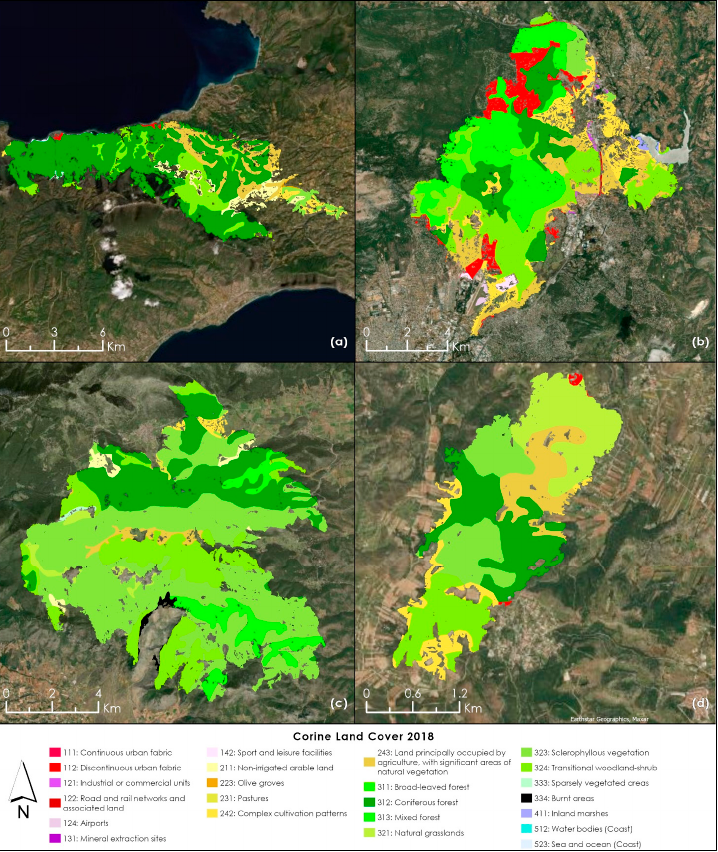
Figure 4. Burned land cover of Attica region wildfires based on Corine Land Cover 2018: ( a ) Schinos; ( b ) Varympompi; ( c ) Vilia; ( d ) Lavreotiki. The third level of Corine Land Cover 2018 was utilized and clipped to each burned area to assess the affected land cover.